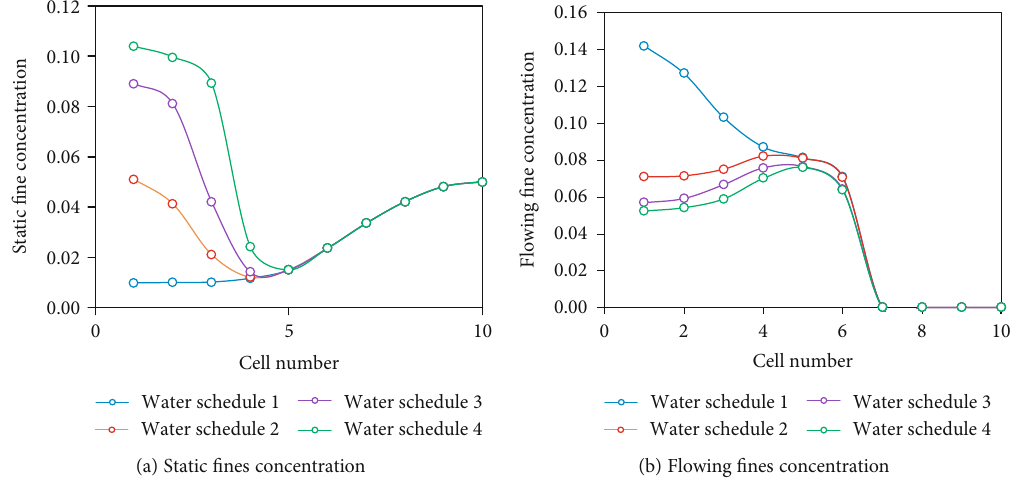
Figure 8: Pro fi les of coal fi nes under di ff erent water